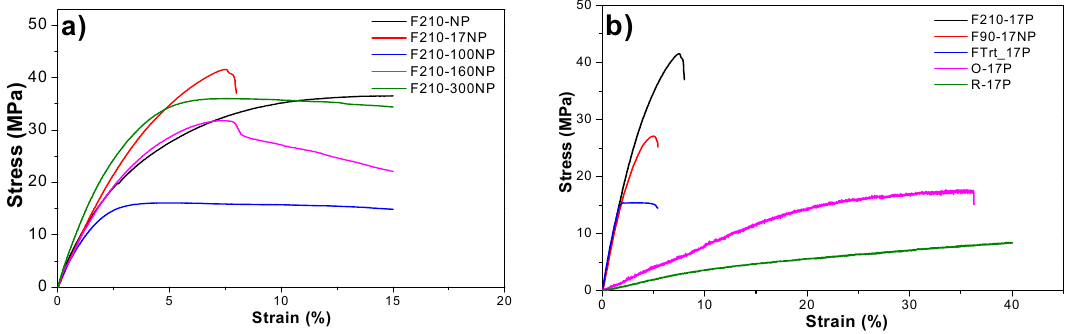
Figure 8. Stress-strain curves for ( a ) SiNPs/PVDF nanocomposites with different SiNPs average diameters within the PVDF matrix and ( b ) for nanocomposites obtained after different processing conditions.